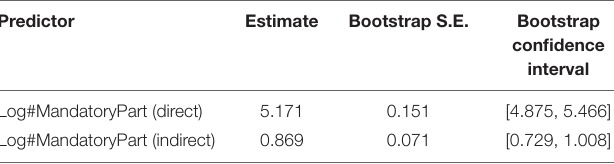
TABLE 5 | Bias corrected indirect effect of the mandatory participation on learner performance ( n = 27,767).